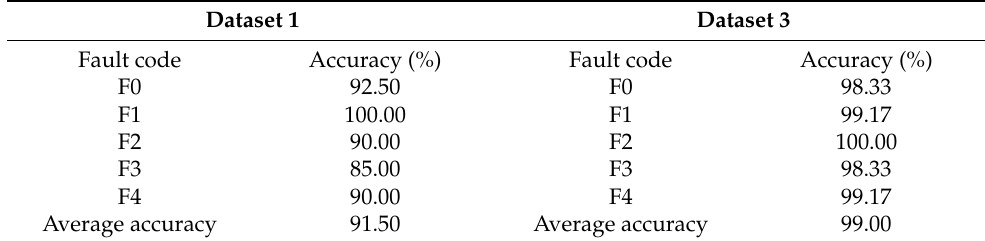
Table 5. Accuracy detail presentation of data sets 1 and 3 in a